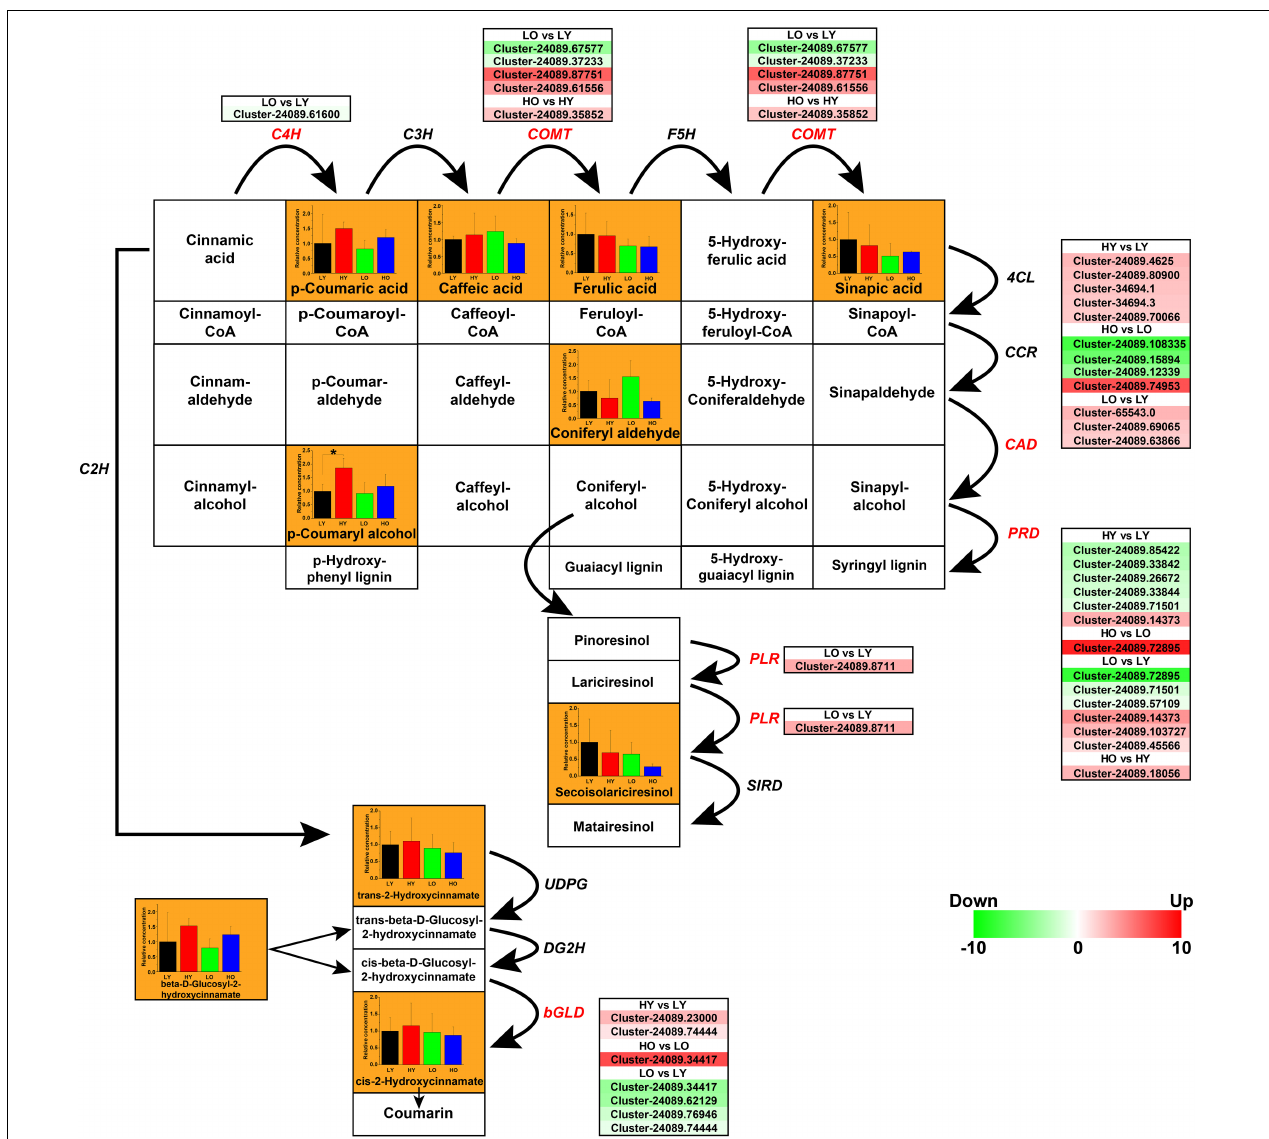
FIGURE 6 | The transcriptomic and metabolic changes of non-flavonoids polyphenolics in the phenylpropanoid biosynthesis. The network of metabolite reactions was rebuilt in the form of a rectangular matrix, containing the names of various substances; the bold black arrows indicated the directions of metabolite reactions. The bar plots exhibiting the relative concentration of the ingredients identified in four comparisons were included in the corresponding rectangles (black LY, red HY, green LO, blue HO. ∗ p < 0.05, Student’s t -test). Each italic abbreviation corresponded to the putative gene that encoded the functional enzyme. The significantly up-regulated (red) and down-regulated (green) unigenes were listed beside the DEGs (red italic